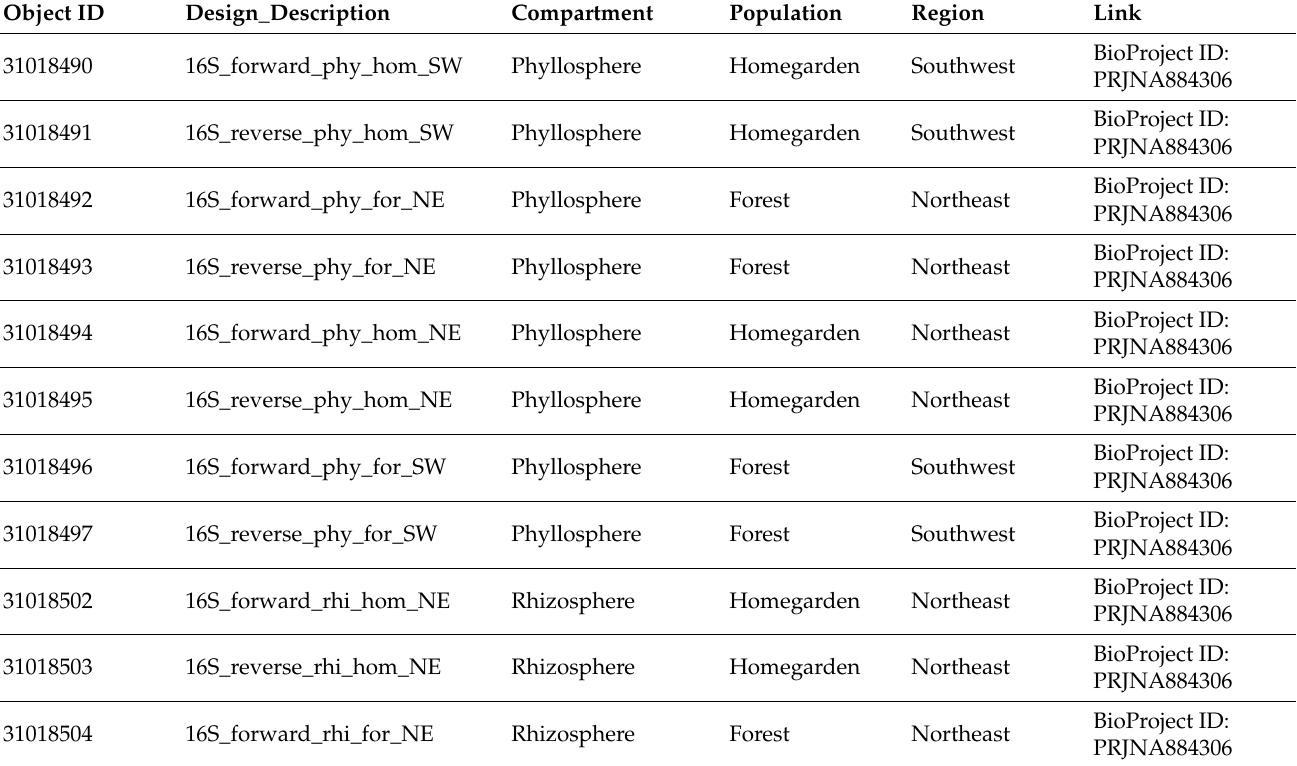
Table A1. Accession numbers (Object ID) and metadata for the 16S and ITS raw sequences from phyllosphere and rhizosphere associated with Cordia dodecandra in forest (Fo) and homegarden (Ho) populations from Southwest and Northeast region in Yucat á